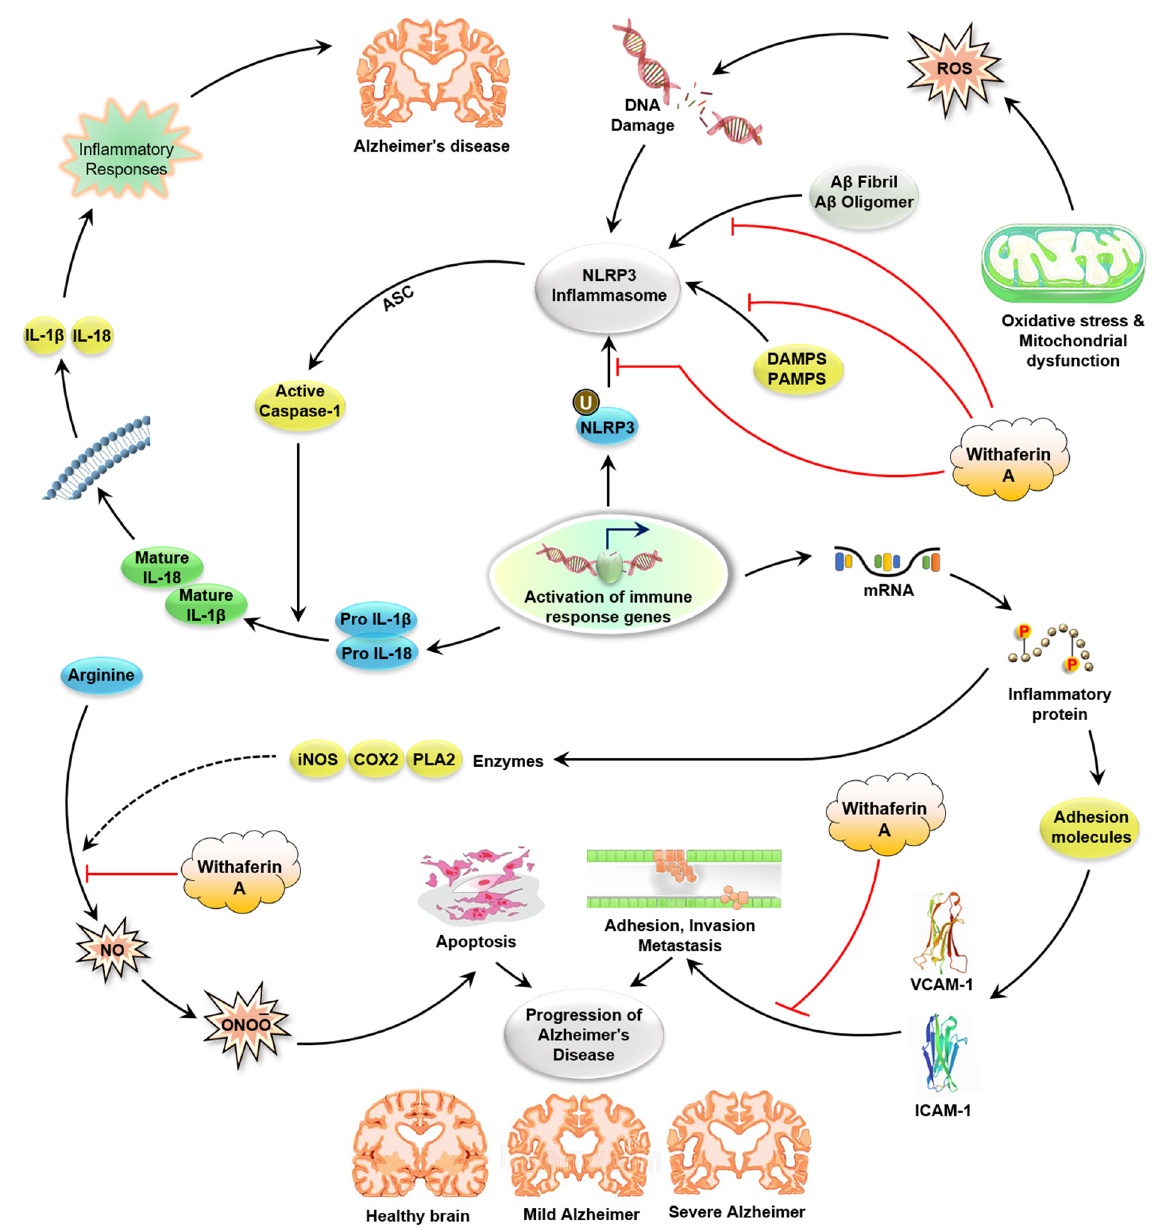
Figure 3. Overview of inflammatory signaling pathways altered by WA through direct molecular targets. Fibrillary A β , oxidative stress, DAMP, and PAMP can contribute to the activation of the inflammasome. A β fibrils trigger the activation of microglial cells and thus give signal 1 via NF- κ B transcription of pro IL-1 β and NLRP3. Intracellular aggregation of soluble A β and lysosomal rupture by phagocytosis A β fibrils may perform another signal, and oxidative stress contributes to the formation of an active NLRP3 inflammasome. Active caspase-1, released from active NLRP3, converts IL-1 β pro to active IL-1 β , which is released into extracellular space and leads to neuroinflammation and finally AD. WA prevents NLRP3 inflammasome formation and activation by blocking several steps of this pathway. Abbreviations: ROS: reactive oxygen species; NLEP3: NOD-like receptor protein 3; DAMP: damage-associated molecular pattern; PAMP: pathogen-associated molecular pattern; COX-2: cyclooxygenase-2; I κ B: inhibitory subunit of NF- κ B; IL-18: interleukin-18; VCAM-1: vascular cell adhesion molecule 1; ICAM-1: intercellular adhesion molecule 1; AD: Alzheimer disease; WA: withaferin A.